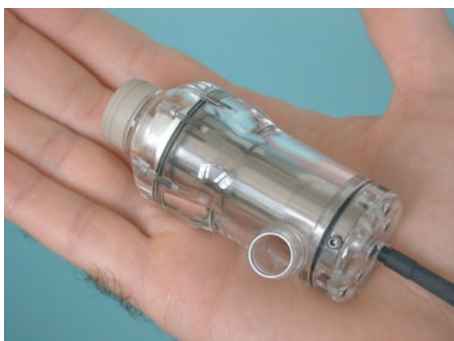
Figure 11 DeltaStream TM .